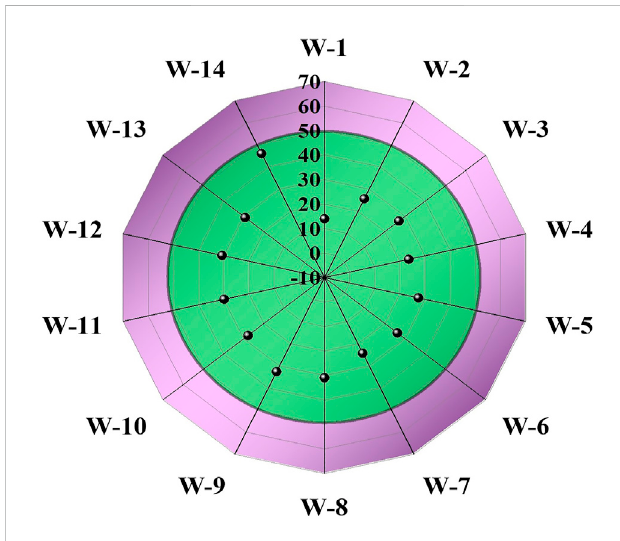
The Radar of water quality index for freshwater